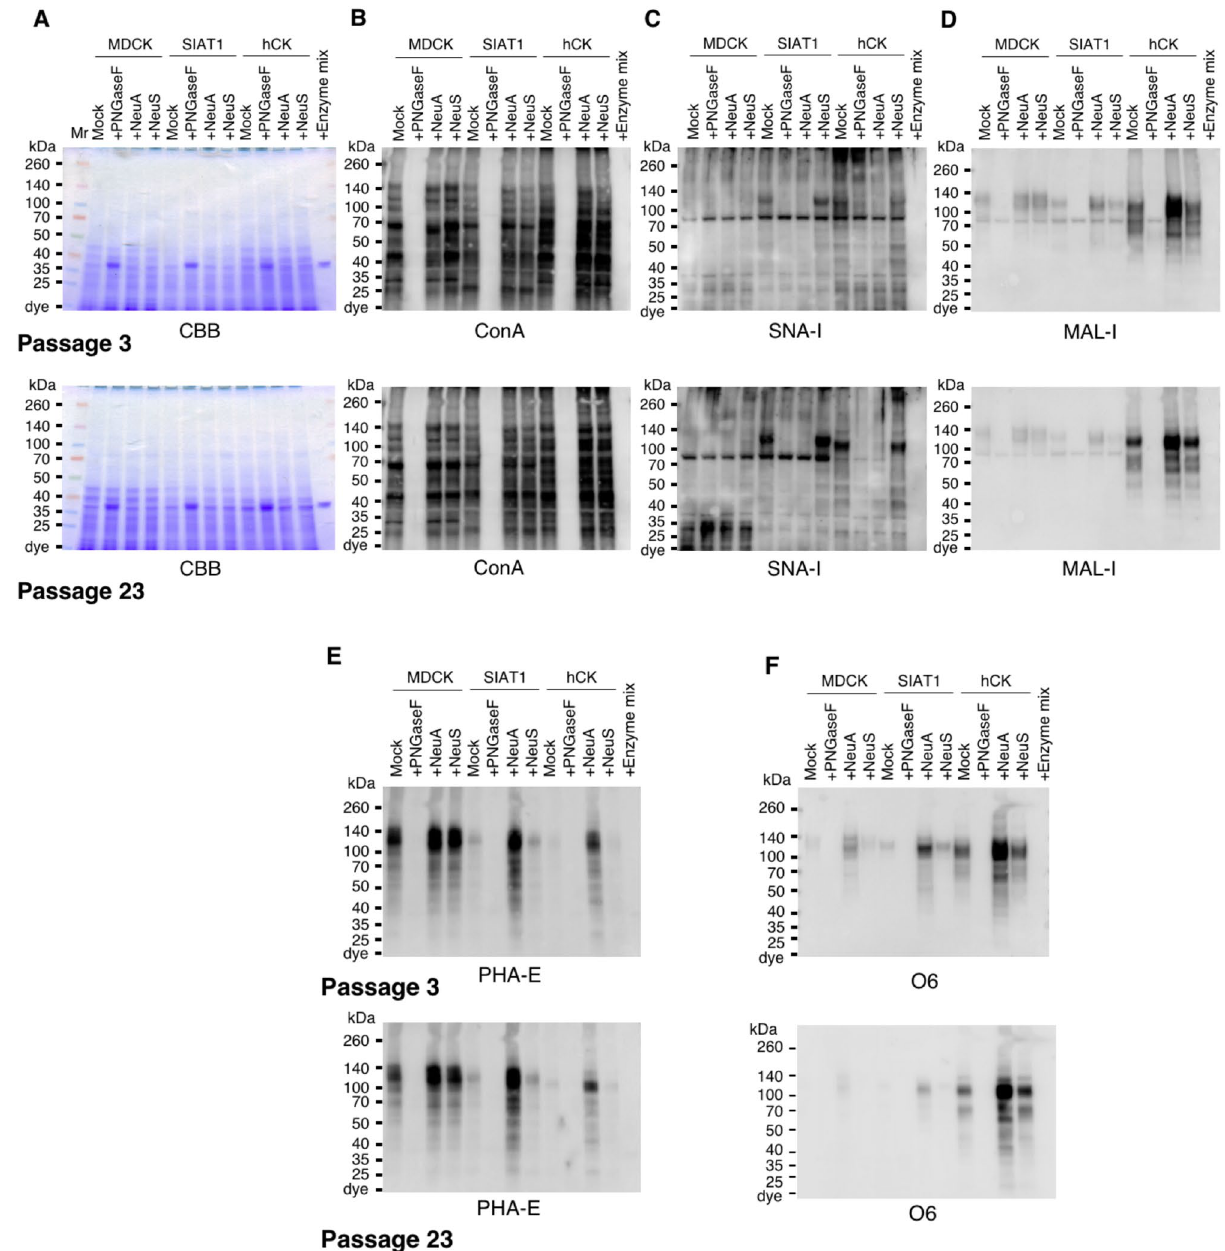
or Neuraminidase S (NeuS), and separated by SDS-PAGE. Total extracts of cells at passage 3 (top) and passage 23 (bottom) ( A–F ), plus PNGaseF/neuraminidases mixture (Enzyme mix) control were loaded on the gels. ( A ) Gel stained with Coomassie Brilliant Blue solution. ( B ) Transferred total glycoproteins analyzed by lectin blot using ConA; ( C ) SNA; ( D ) MAL-I; and ( E ) PHA-E. ( F ) Total glycoproteins from cells at passage 3, and 23 were Western blotted with the antibody